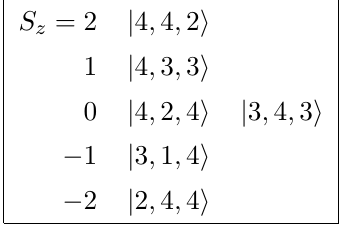
Table 5 . The states of L (4 ; 4 ; 2).